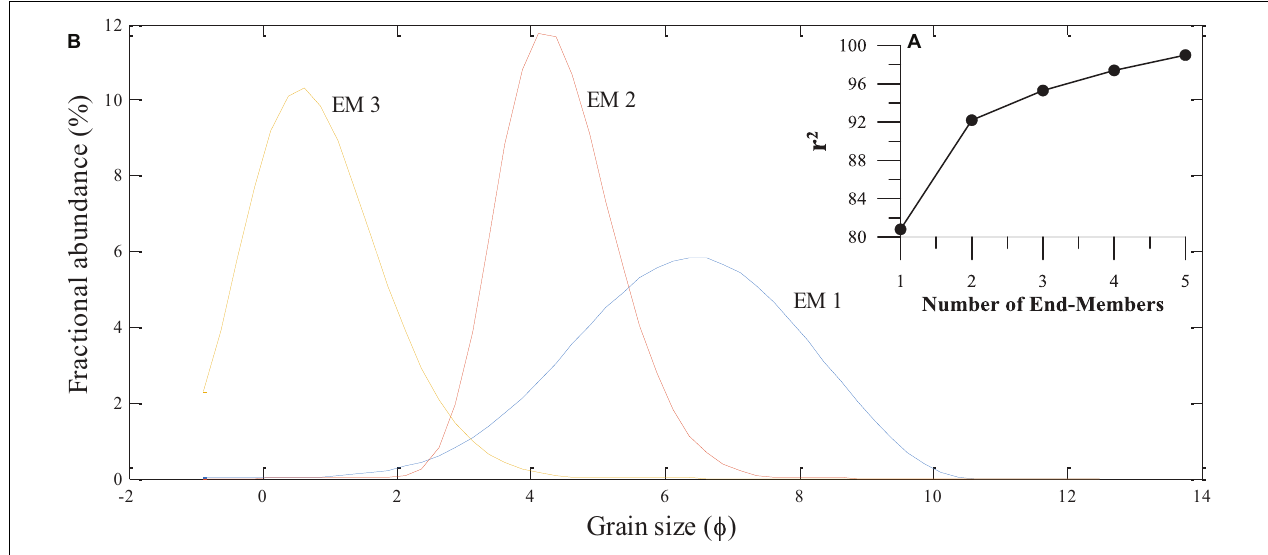
FIGURE 4 | (A) Fraction of data variance explained by the unmixing model vs. numbers of end-members. (B) Volume percent vs. grain-size ( (cid:56) ) diagram of the three end-members (EM1, EM2, and EM3) identified in Core K17.